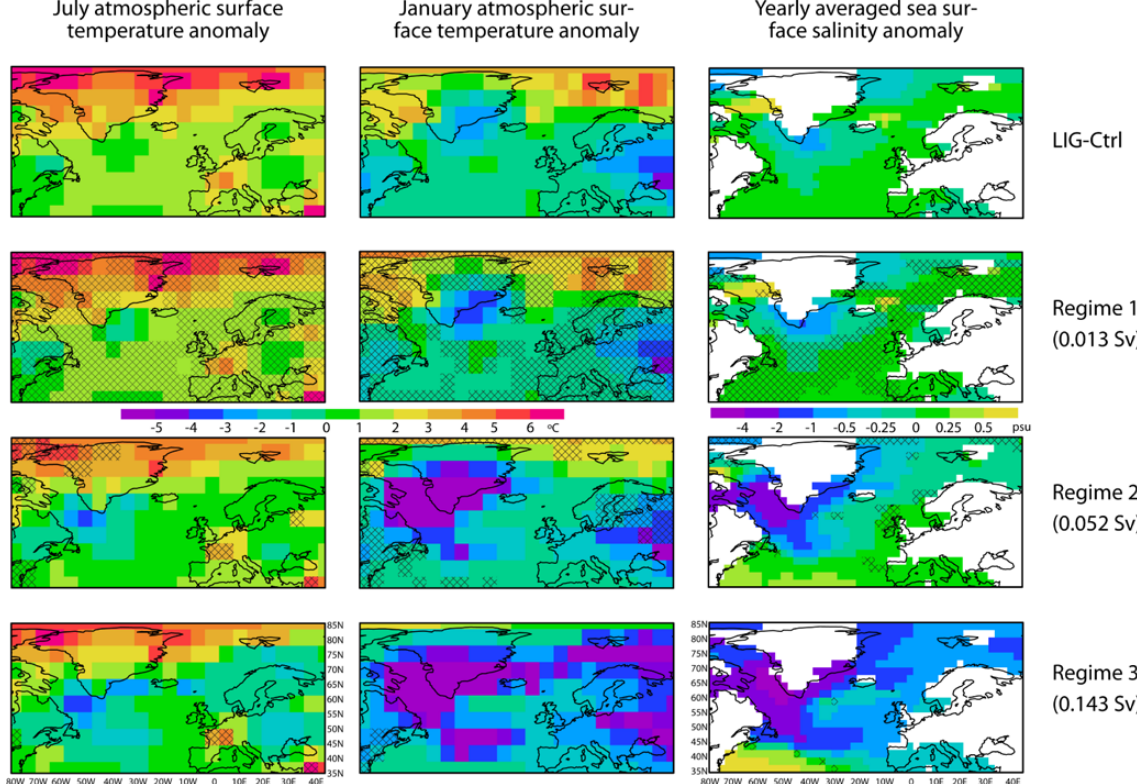
Fig. 5. Climate anomalies in the North Atlantic region for the LIG-ctrl simulation (top panel) and the 3 climate regimes, compared to PI. Left: July atmospheric surface temperatures ( ◦ C); middle: January atmospheric surface temperatures ( ◦ C); right: sea surface salinity (psu). Non-hatched areas indicate the regions for which the simulated anomalies are significantly different at the 5% significance level from the LIG-ctrl anomalies with respect to internal climate variability in the LIG-ctrl simulation (calculated with a